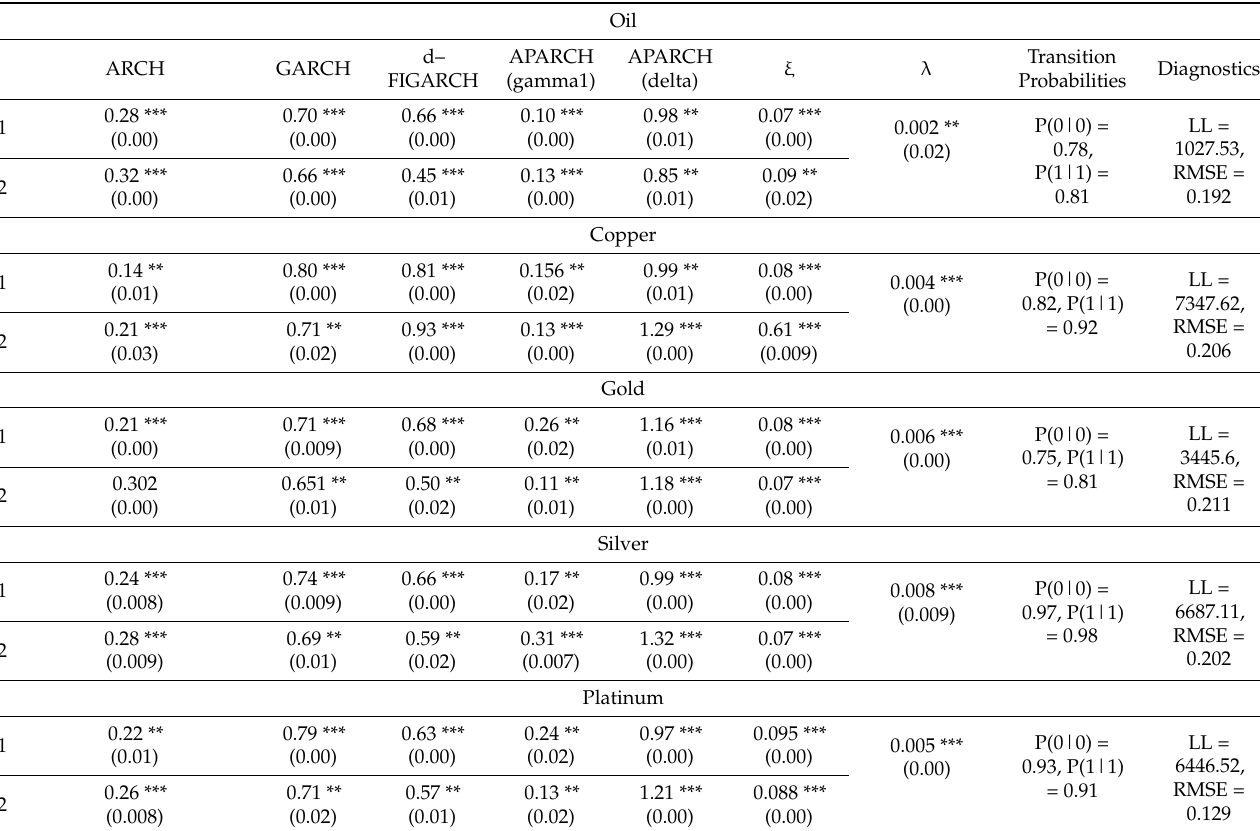
Table 7. MS–FIAPGARCH–MLP–Copula